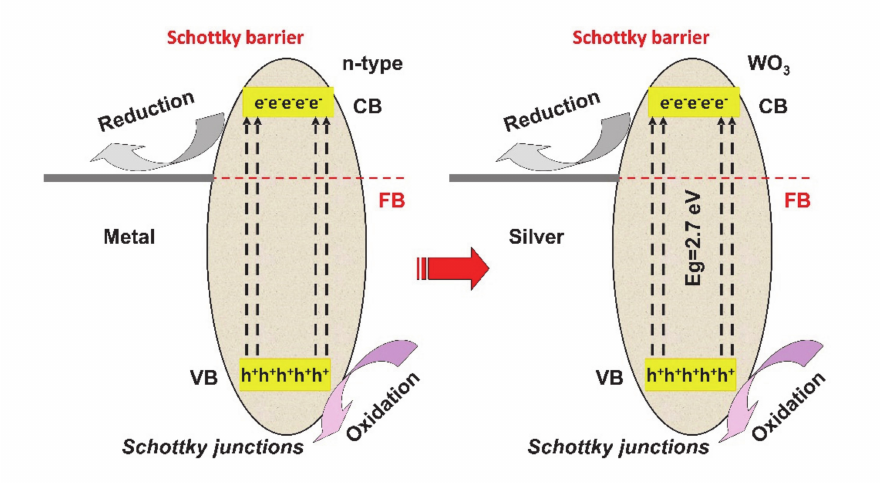
Figure 4. Schottky junction’s mechanism.